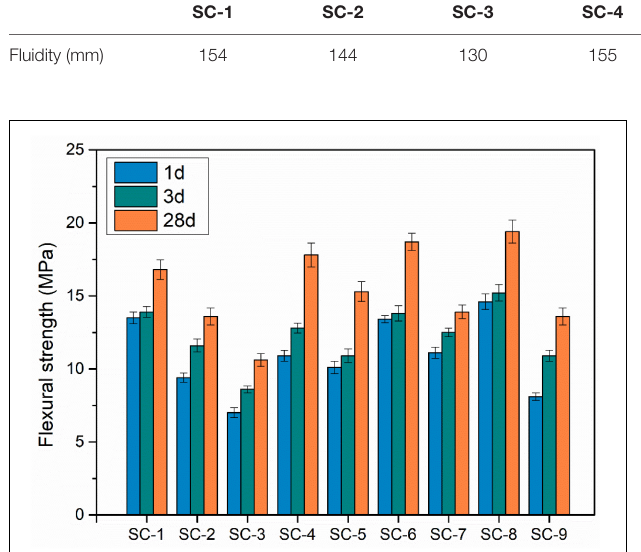
FIGURE 7 | Compressive strength of CSA-ECC specimens after curing for 1, 3, and 28 days.